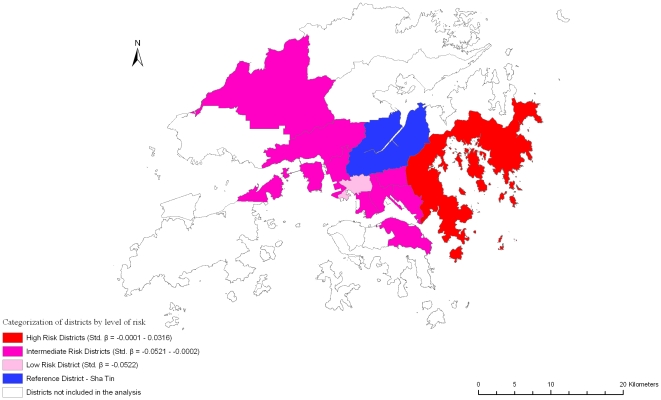
Risk variation in frailty (Log Frailty Index) across districts.